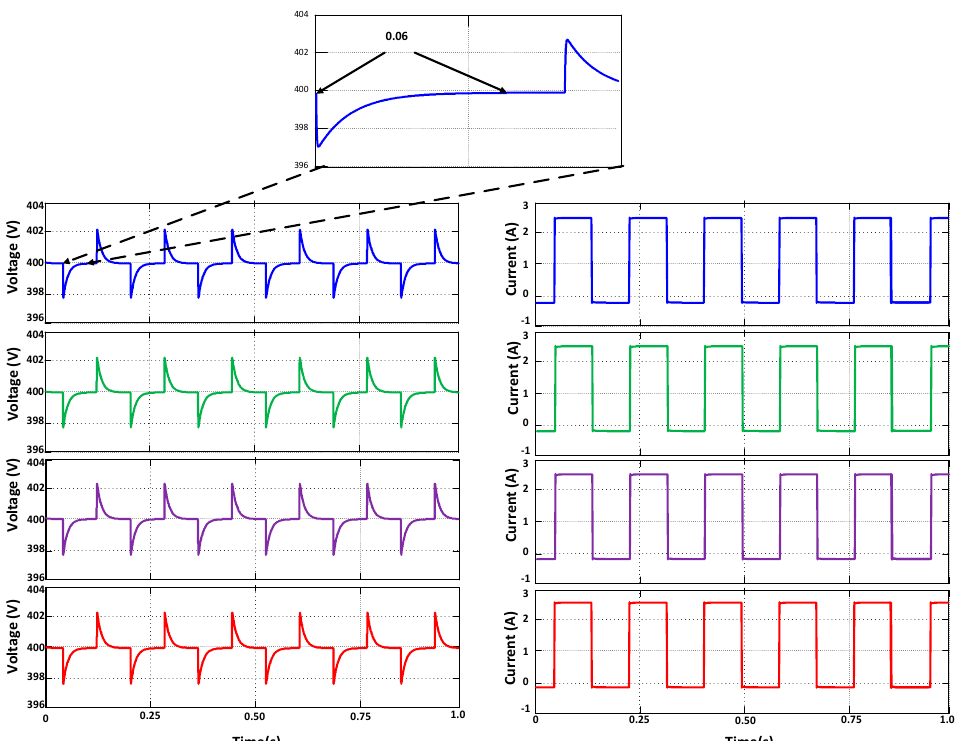
Figure 13. Current and voltage waveforms response of the existing technique [13] with disturbance signal.